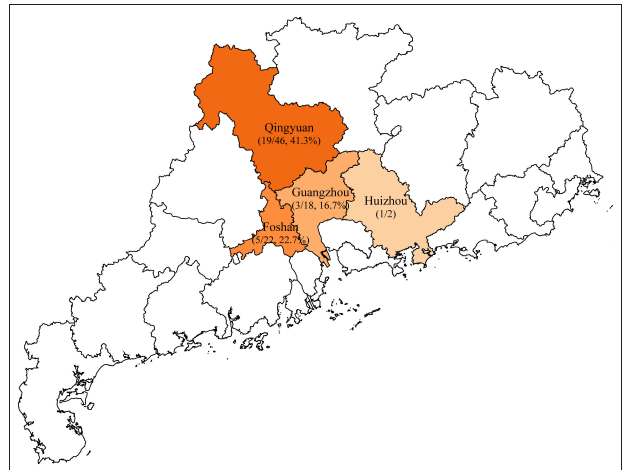
FIGURE 1 | Sample collection areas in Guangdong, China. Municipalities included in the study are shaded in orange and the rate of bla NDM -positive Escherichia coli isolates are indicated by the depth of